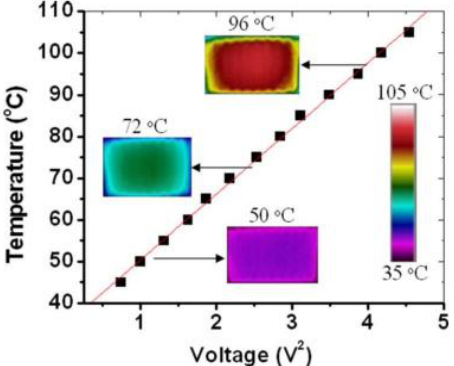
Figure 15. Temperature in the working channel as a function of the squared input voltage. The three insets are IR images illustrating the spatial distribution. Reprinted with permission from [67]. Copyright 2009, American Institute of